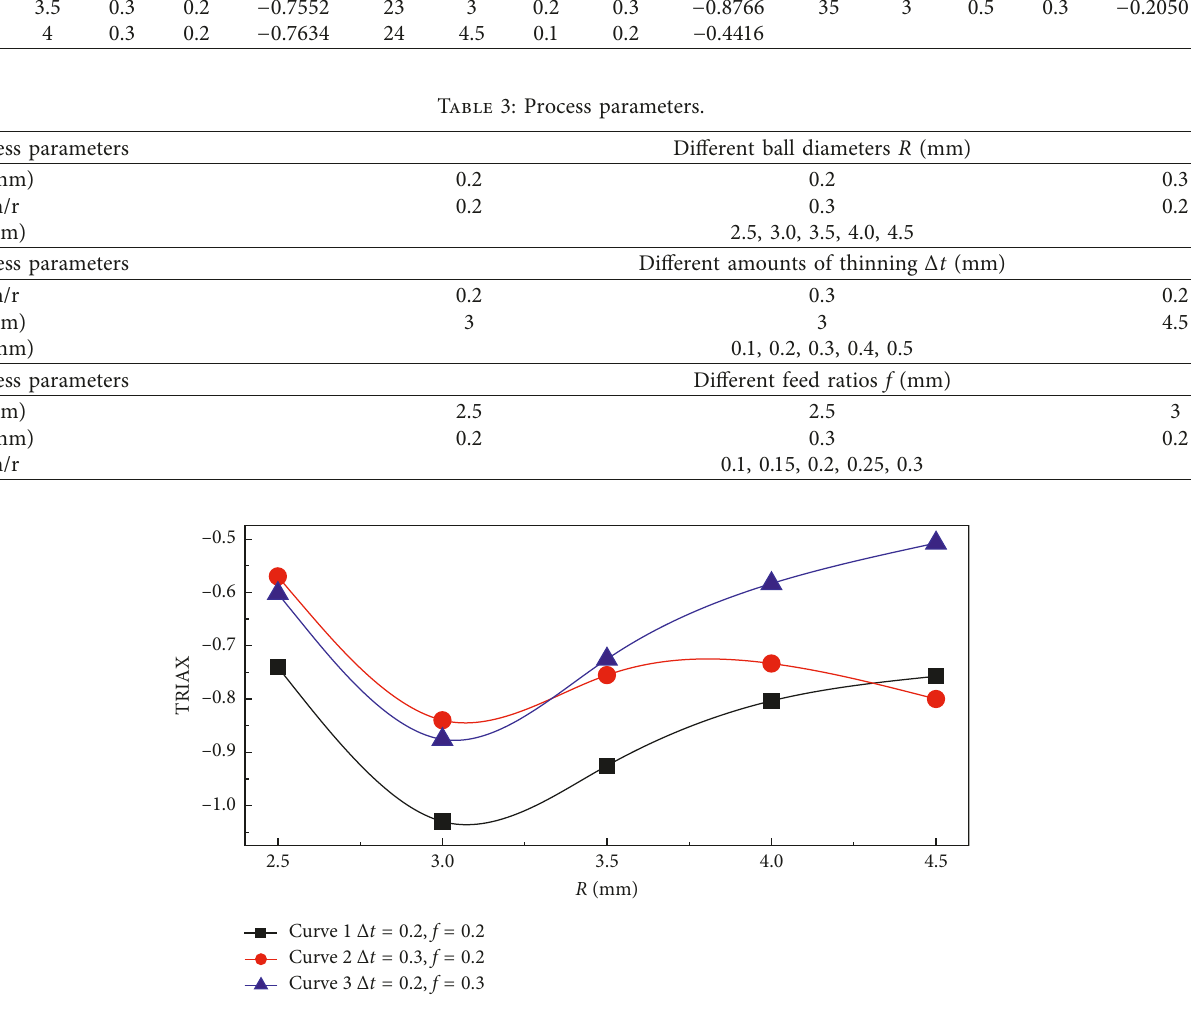
Figure 5: Graph of change in AVRST with ball